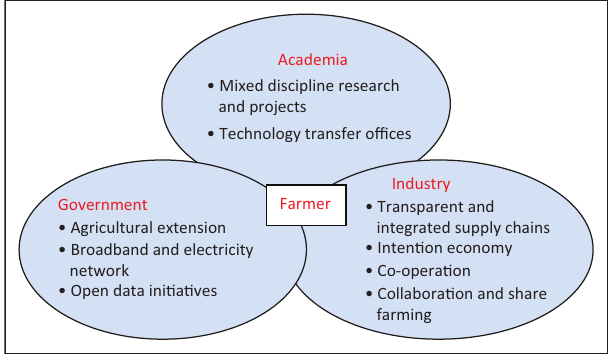
FIGURE 4: Digital innovation